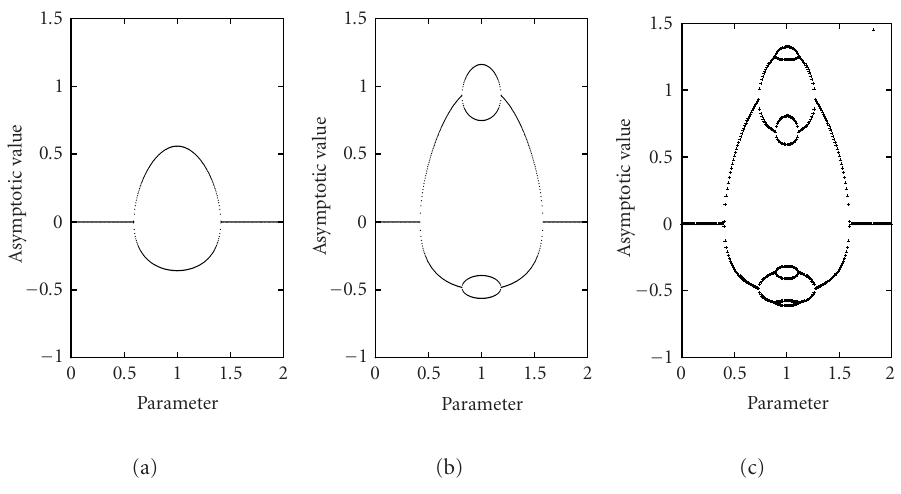
Figure 4.1. Regular reversal maps for (a) α 0 = 1 . 2, (b) α 0 = 1 . 5, and (c) α 0 = 1 . 562.